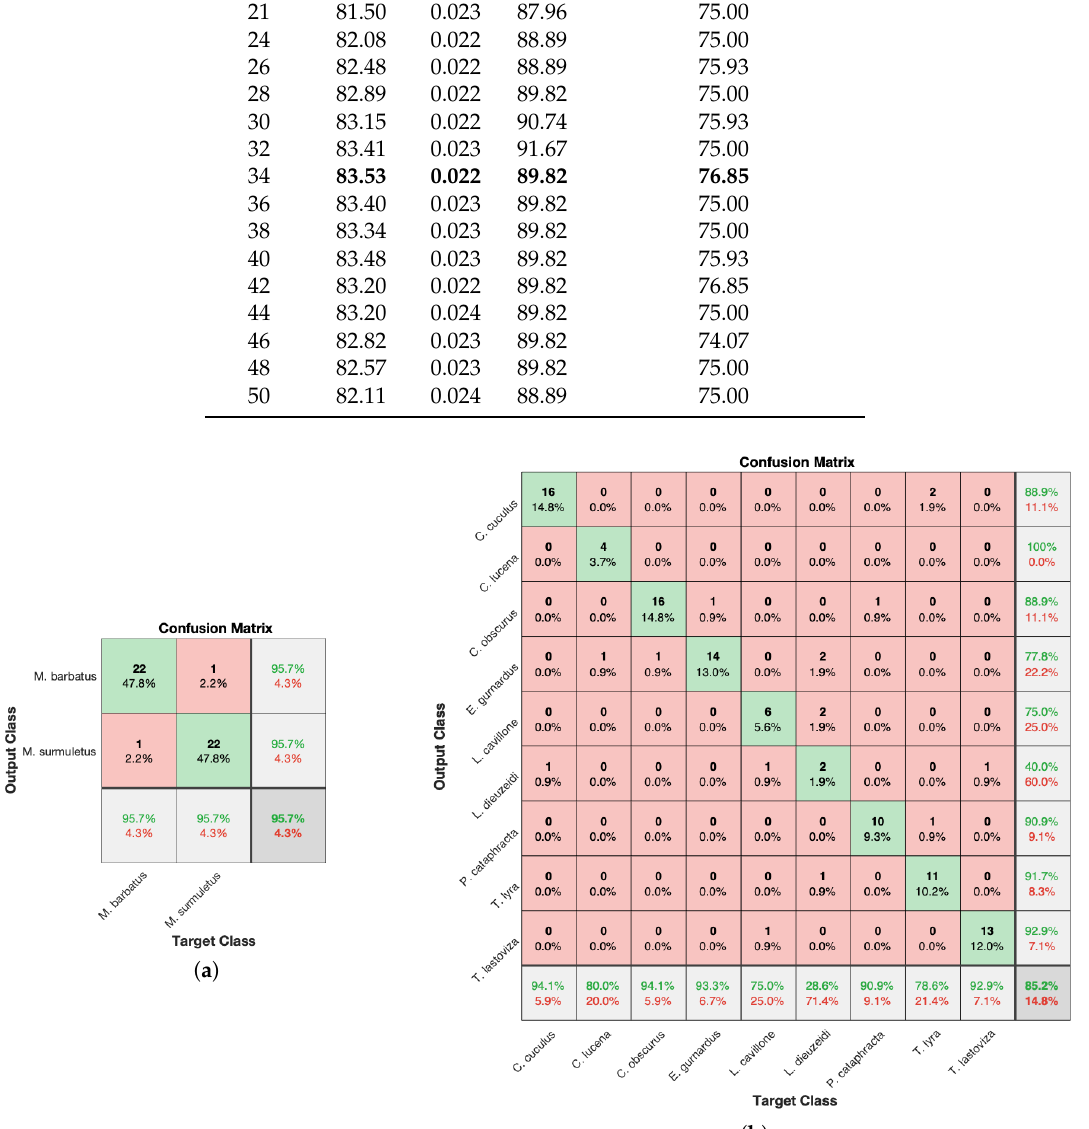
Figure 11. ( a ) The confusion matrix of binary-classification realization with an accuracy value of 95.7%. The results were obtained by performing LOO-CV using five features based on the DFT with a SLFN of 10 hidden nodes. The mean accuracy value after performing 1000 LOO-CV iterations was 89.3%. ( b ) The confusion matrix of multi-class classification realization with 85.2% accuracy. The results were obtained by performing LOO-CV using five features based on the DCT plus five more based on the DFT, with an SLFN of 30 hidden nodes. The mean accuracy value after performing 1000 LOO-CV iterations maintaining the same SLFN size was